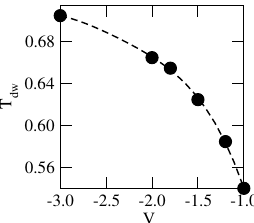
-3.0 -2.5 -2.0 -1.5 -1.0 V o Figure 9. The dewetting transition temperature versus V o , for the systems with u AB = 0 and u BB = −